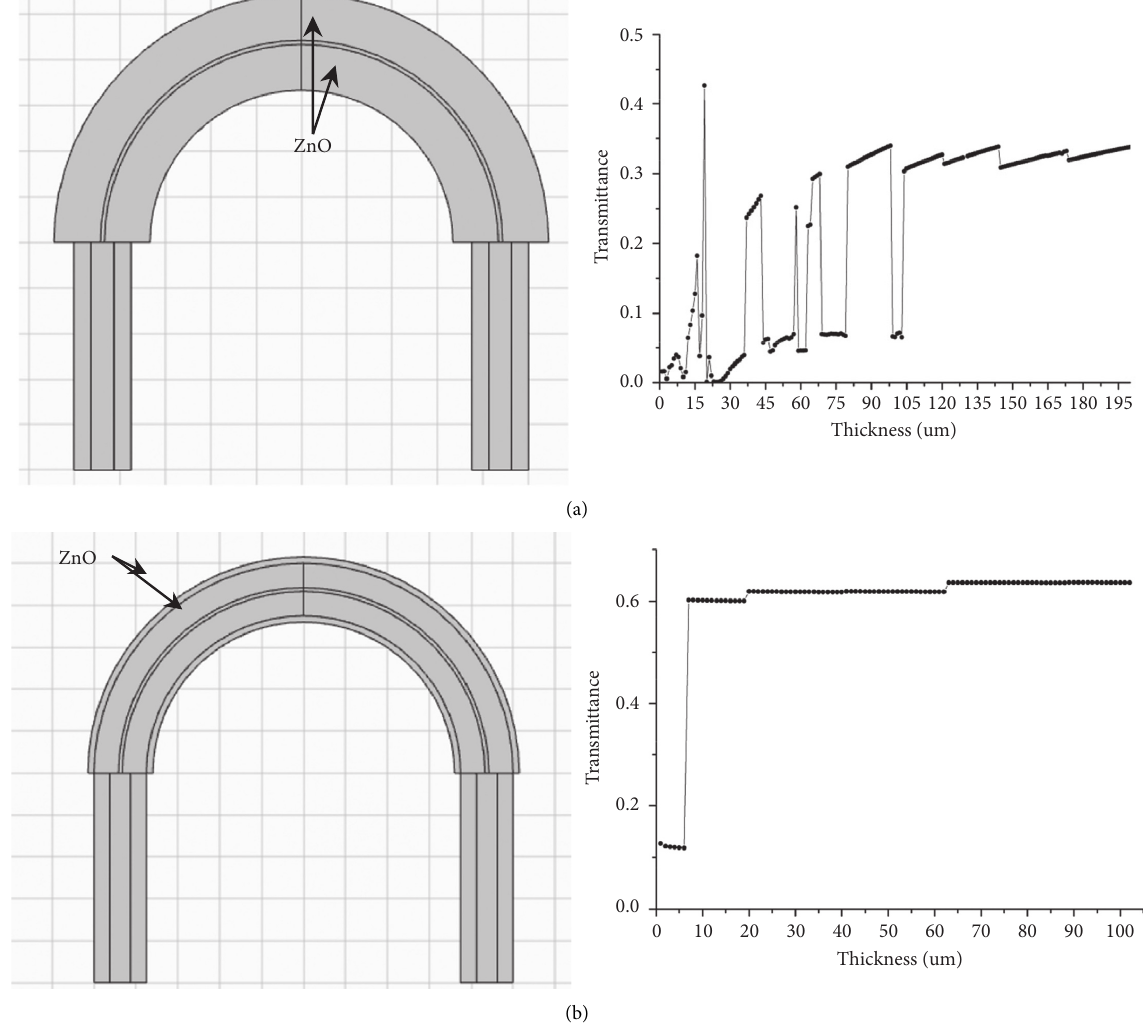
Figure 8: Structure of heterocore macrobend fiber optic with its transmittance graph: (a) ZnO as a cladding and (b) ZnO as a second